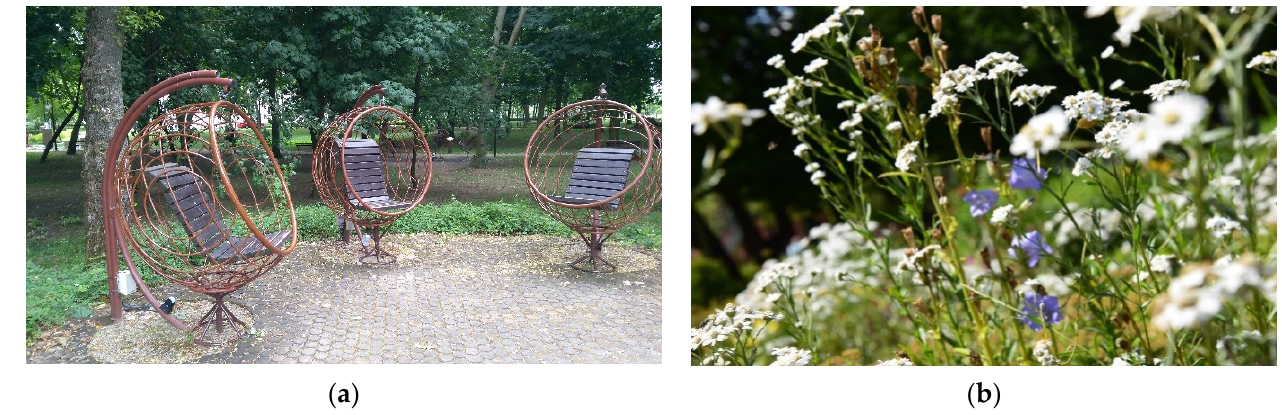
Figure 2. Scents and sounds, ( a ) Podd ę bice (Fot. A. Lubarska), ( b ) Owi ń ska (Fot. A. Zajadacz).